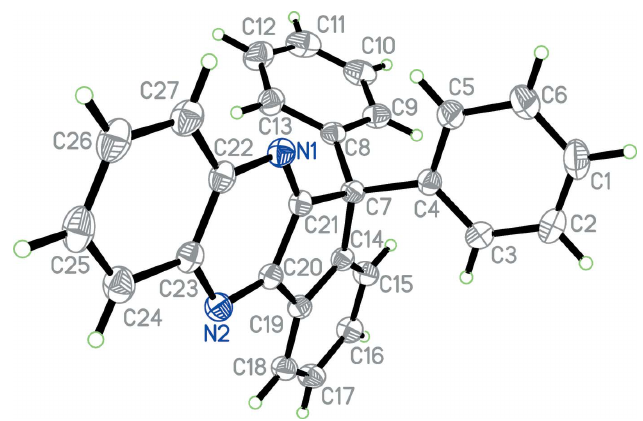
Figure 1 The molecular structure of the title molecule with displacement ellipsoids drawn at the 30% probability